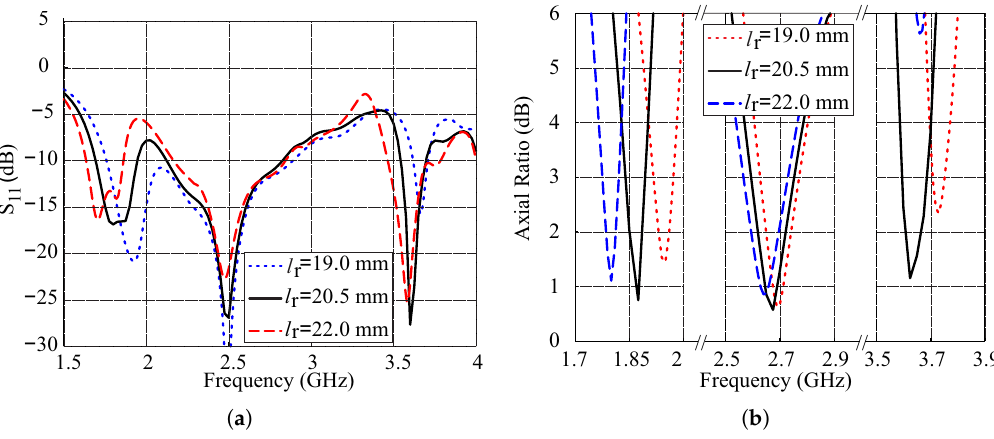
Figure 7. Simulated effects of variations in length l r of the SMR: ( a ) Reflection coefficients; ( b ) Axial